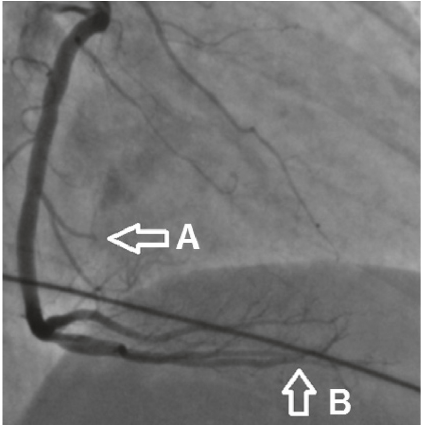
Figure 2: Coronary angiogram showing an occlusion of the small acute marginal branch (A) of the right coronary artery with slow flow in the posterior descending artery (B).